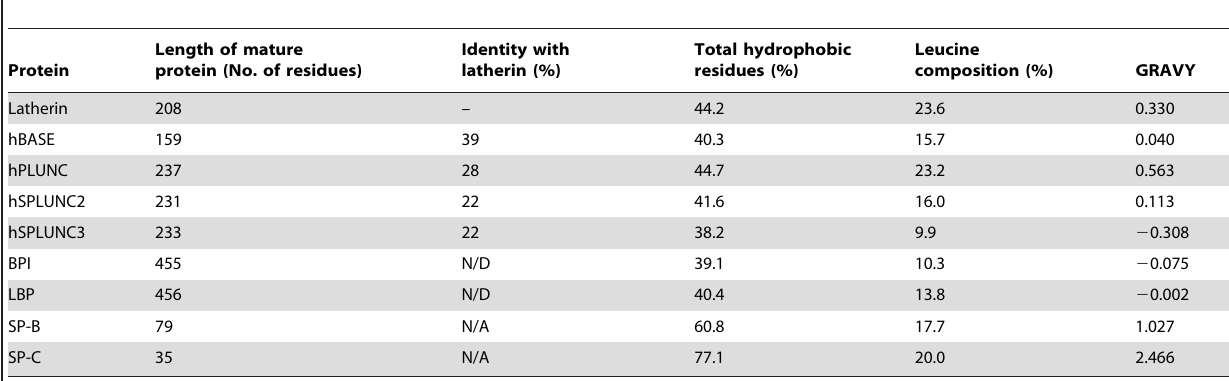
Table 1. Comparison of hydrophobicity between latherin and human PLUNC family members.